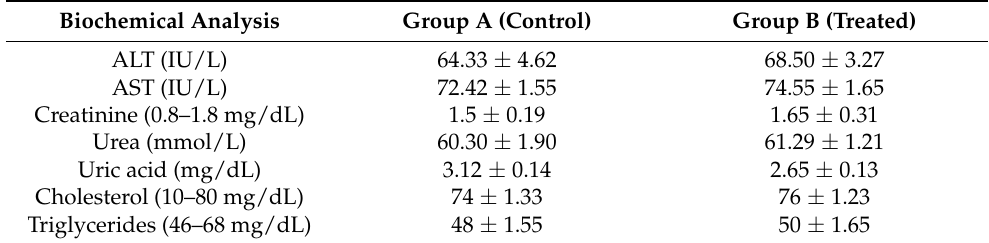
Table 7. Liver, renal, and lipid profiles after administration of hydrogel microparticles.